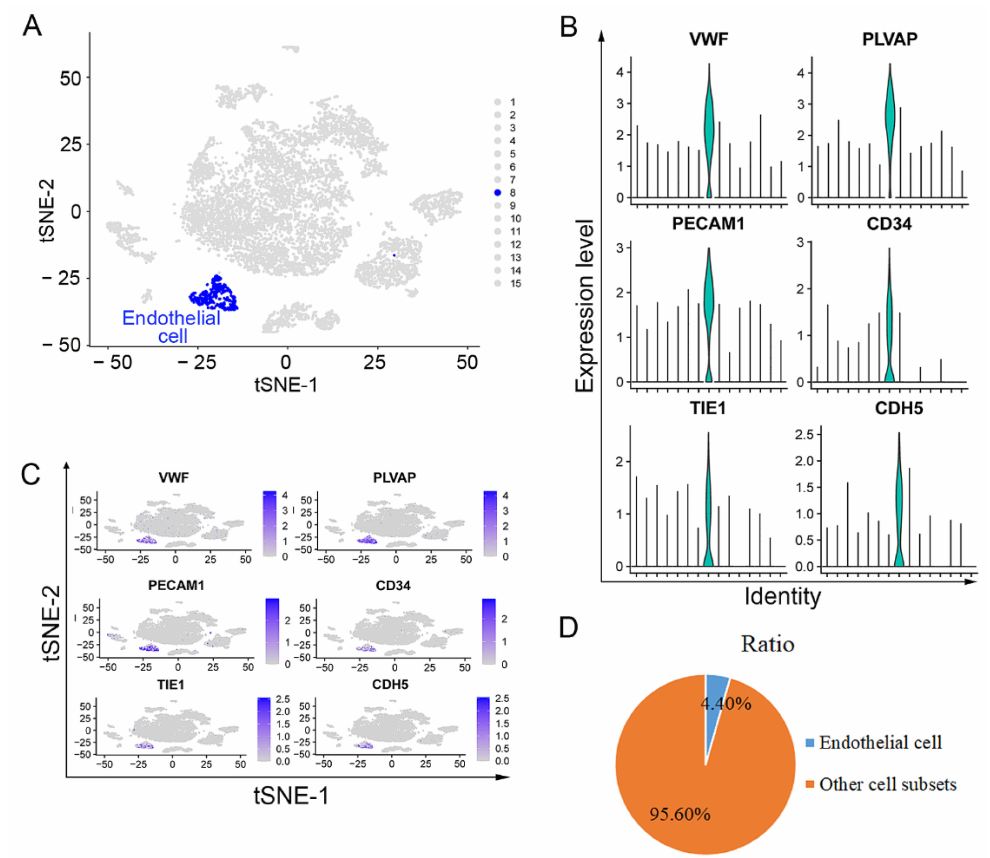
Figure 1. Gene profile of endothelial cells in human upper ESCC with scRNA sequencing: ( A ) tSNE map of total 9891 high-quality cells and the cluster visualization of endothelial cells; blue dots: endothelial cells. ( B ) expression levels of VWF , PLVAP , PECAM1 , CD34 , TIE1 , and CDH5 in 9891 cells illustrated as Violin plots; and ( C ) tSNE map; ( D ) ratio of endothelial cells and other cell